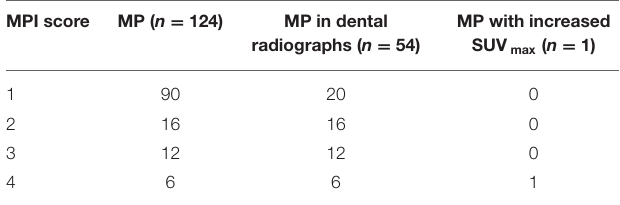
TABLE 2 | Marginal periodontium (MP) in dental X-rays and